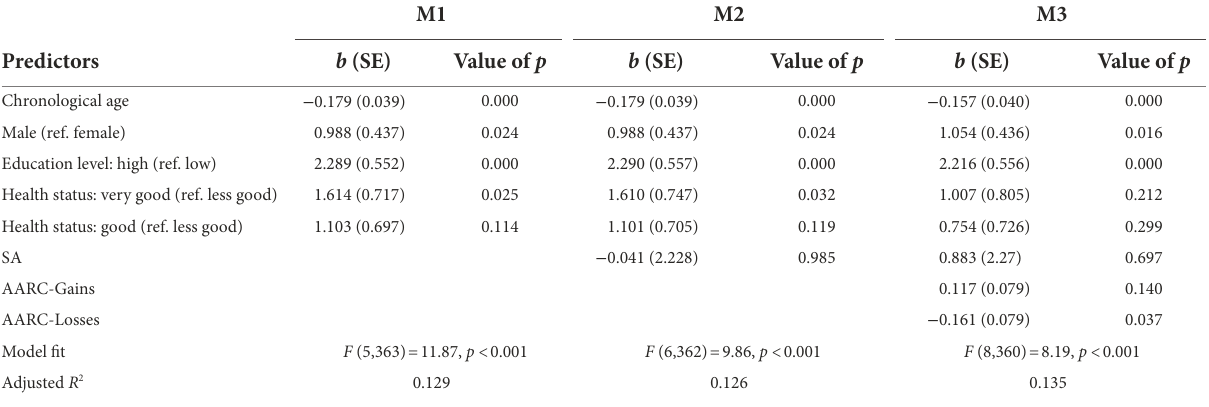
TABLE 4 Stepwise linear regression analyses to predict technology